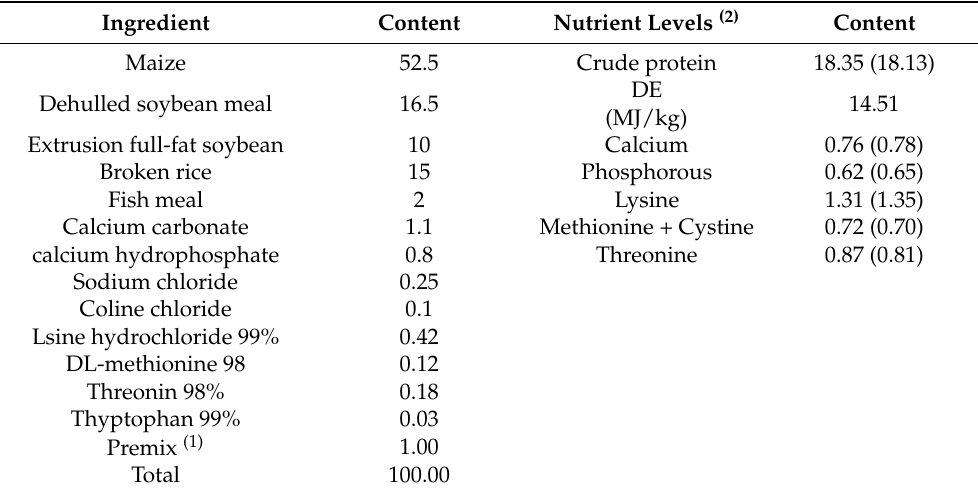
Table 1. Composition and nutrition levels of the basal diets (as-fed